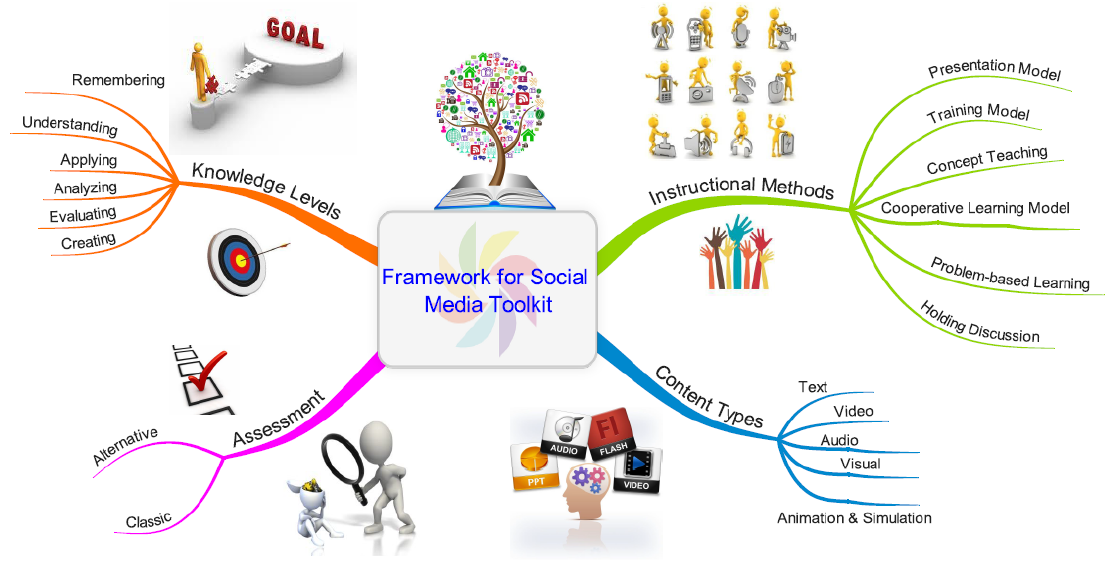
Figure 1 . Framework for the Social Media